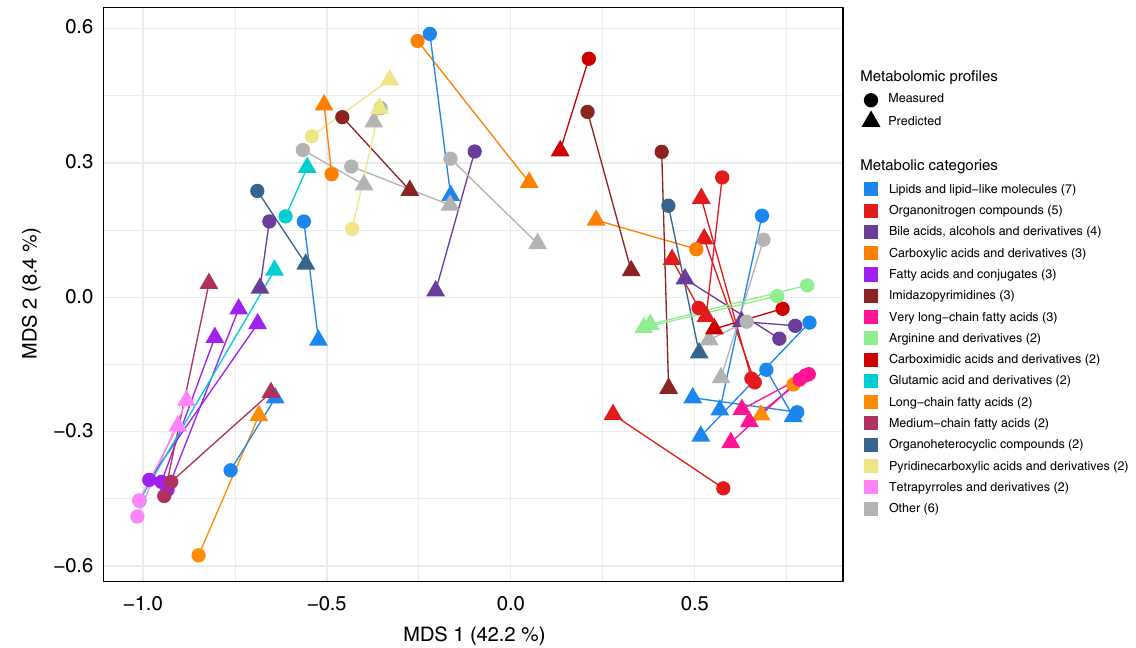
Fig. 4 Predicted and measured metabolite pro fi les reveal similar global structure in the in fl ammatory bowel disease (IBD) microbiome. Principal coordinate analysis (PCoA) of top 50 well-predicted unique metabolite clusters whose identities were con fi rmed against laboratory standards, using a Spearman distance matrix. Metabolites in the PCoA plot are coloured by their labels and shaped by whether they were measured or predicted, and for each metabolite, the measured and predicted abundances are connected by edges, demonstrating closeness of measured and predicted metabolites across 65 Netherlands IBD (NLIBD) samples in the two-dimensional multidimensional scaling (MDS)